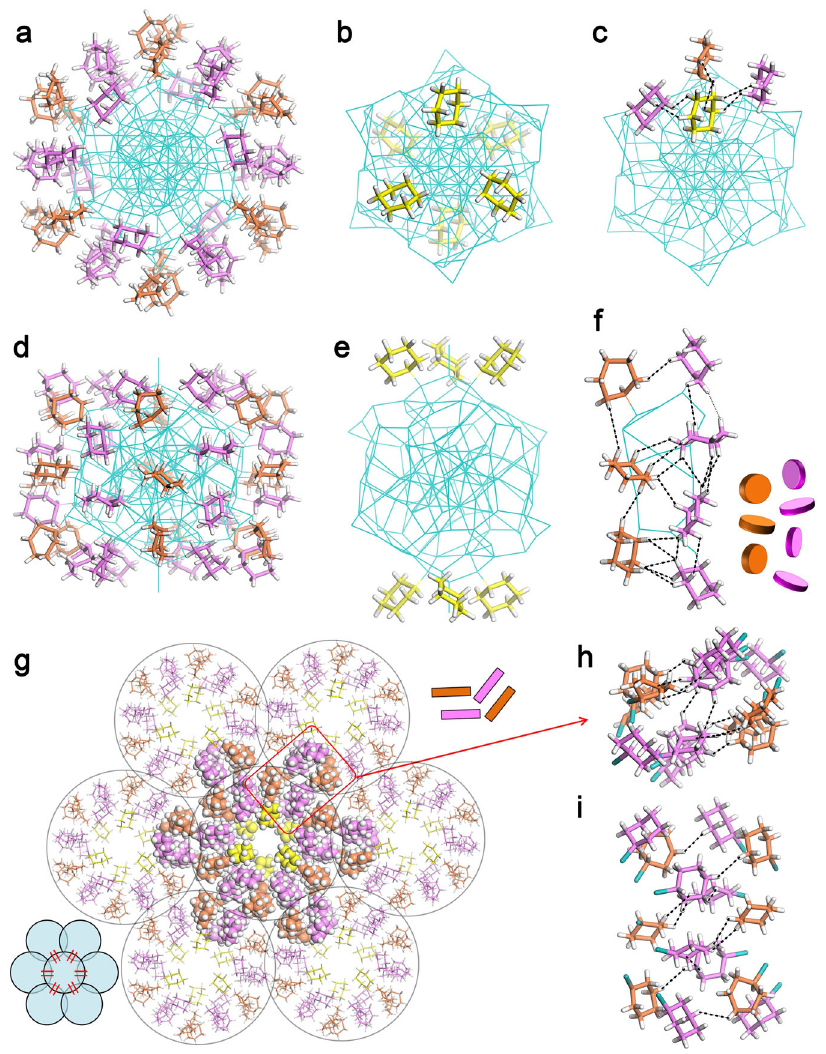
Fig. 2 | Surface pattern of the ligands on Ag 77 Cu 22 NCs. The ligands are dis- tributed perpendicular to the waist ( a ) or on the poles ( b ). c Interactions between the pole ligands and their surrounding ligands. d , e side views of a and b . f Interactionsbetweentheligandsperpendiculartothewaist. g Sevenclose-packed